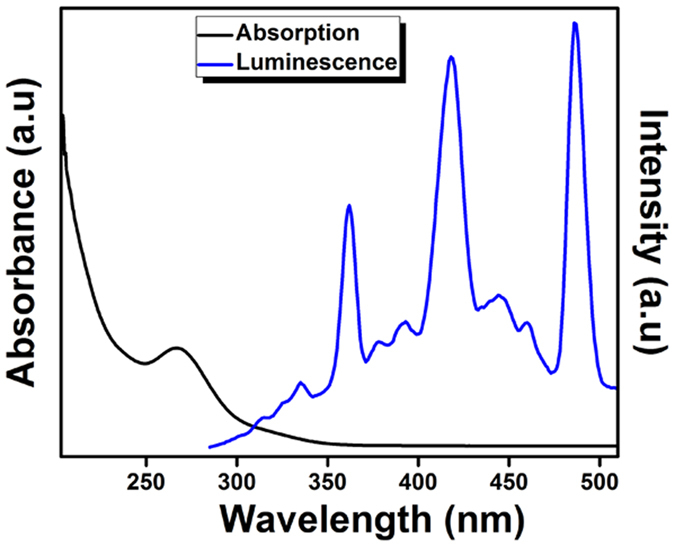
Absorption (Black line) and luminescence spectra (Blue line) for Gd doped t-LaVO4 nanoparticles.